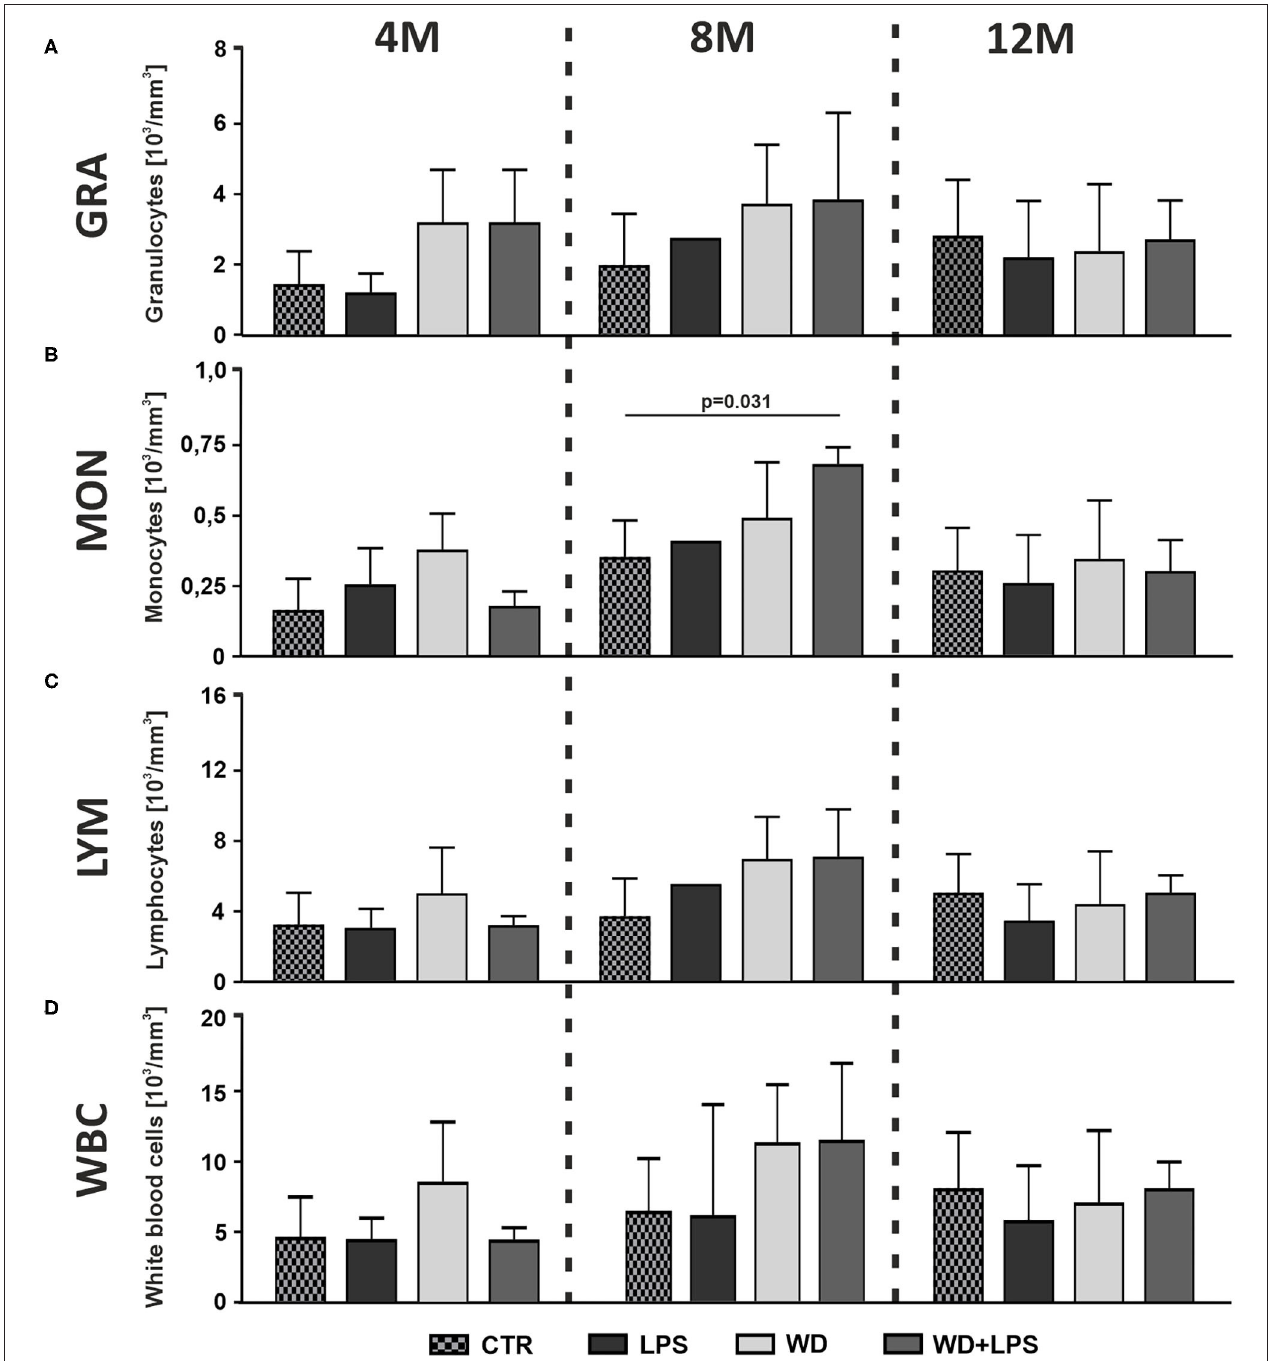
FIGURE 3 | Western diet induces low-grade systemic inflammation. Graphs show WD-induced increases of (A) blood granulocytes (GRA) concentration in 4- and 8-month-old APPswe mice, (B) monocytes (MON) concentration in 4- and 8-month-old APPswe mice, (C) lymphocytes (LYM) concentration in 8-month-old APPswe mice and (D) total white blood cells (WBC) concentration in 8-month-old APPswe mice. All the data are presented as arithmetic mean ± SD ( n = from 3 to 8 animals per experimental group with exception in 8M LPS groups where means were calculated based on n = 2, and these values were not included in statistical analysis). The statistics were calculated using one-way analysis of variance (ANOVA) followed by Bonferroni’s post-test or non-parametric Kruskal-Wallis test followed by Dunn’s post-test. A p -value of < 0.05 was considered a predetermined threshold for statistical significance.